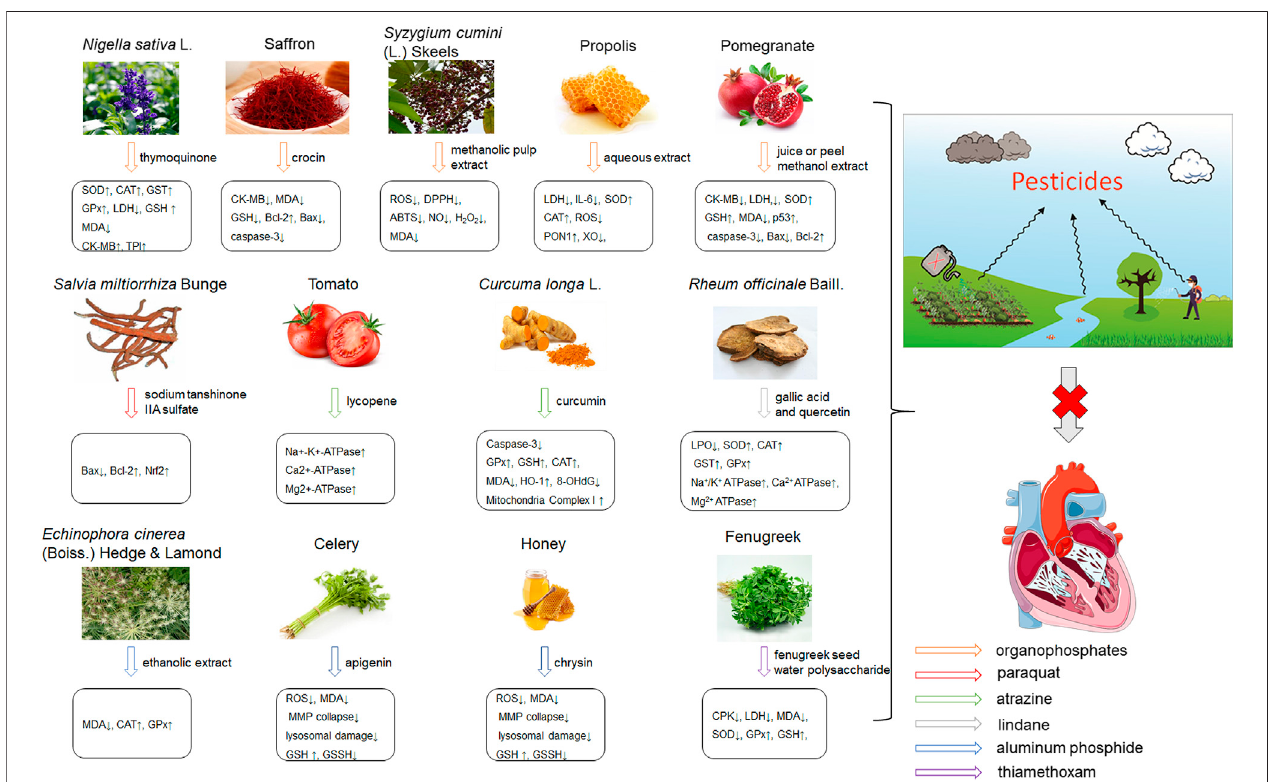
FIGURE 3 | The pesticides exposure routes and protective mechanisms of natural products against pesticides-induced cardiotoxicity. LPO, Lipid Peroxide; TPI, troponin; 8-OhdG, 8-hydroxydeoxyguanosine; PON1, paraoxonase-1.